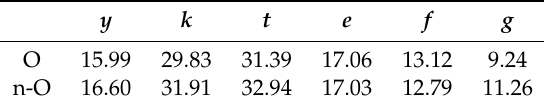
Table 10. Weighted equilibrium